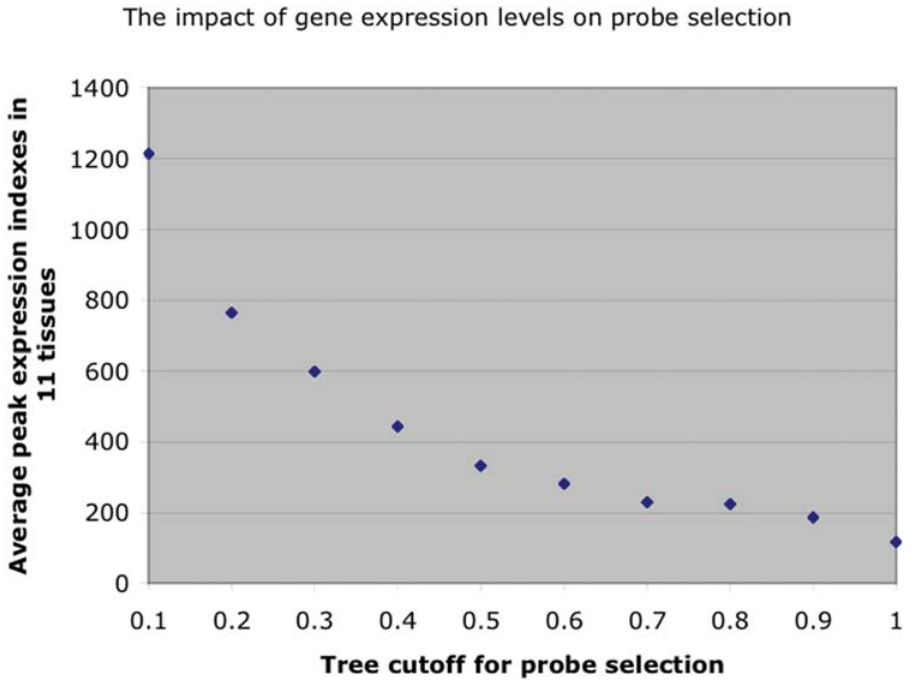
Figure 6. The impact of gene expression levels on probe selection. We grouped 17056 transcript clusters into ten distinct bins according to the height where we cut the clustering dendrogram ( h_final ). For each transcript cluster, we calculated its peak gene expression index in the 11 tissues using selected probes. Then we took an average for each bin. The values of tree cutoff (X-axis) were negatively correlated with average peak gene expression levels in the 11 tissues (Y-axis).